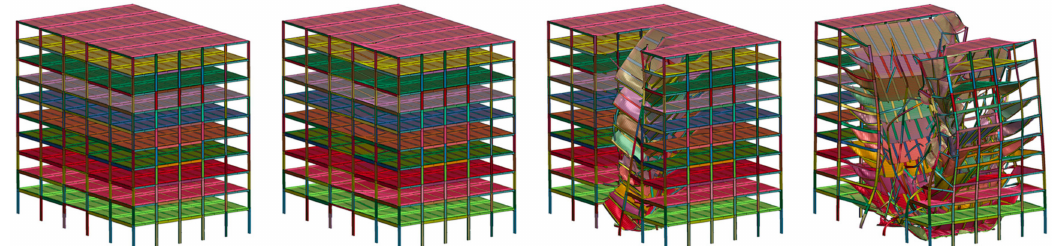
Figure 27. Response of model M1 subjected to sudden loss of column D5.